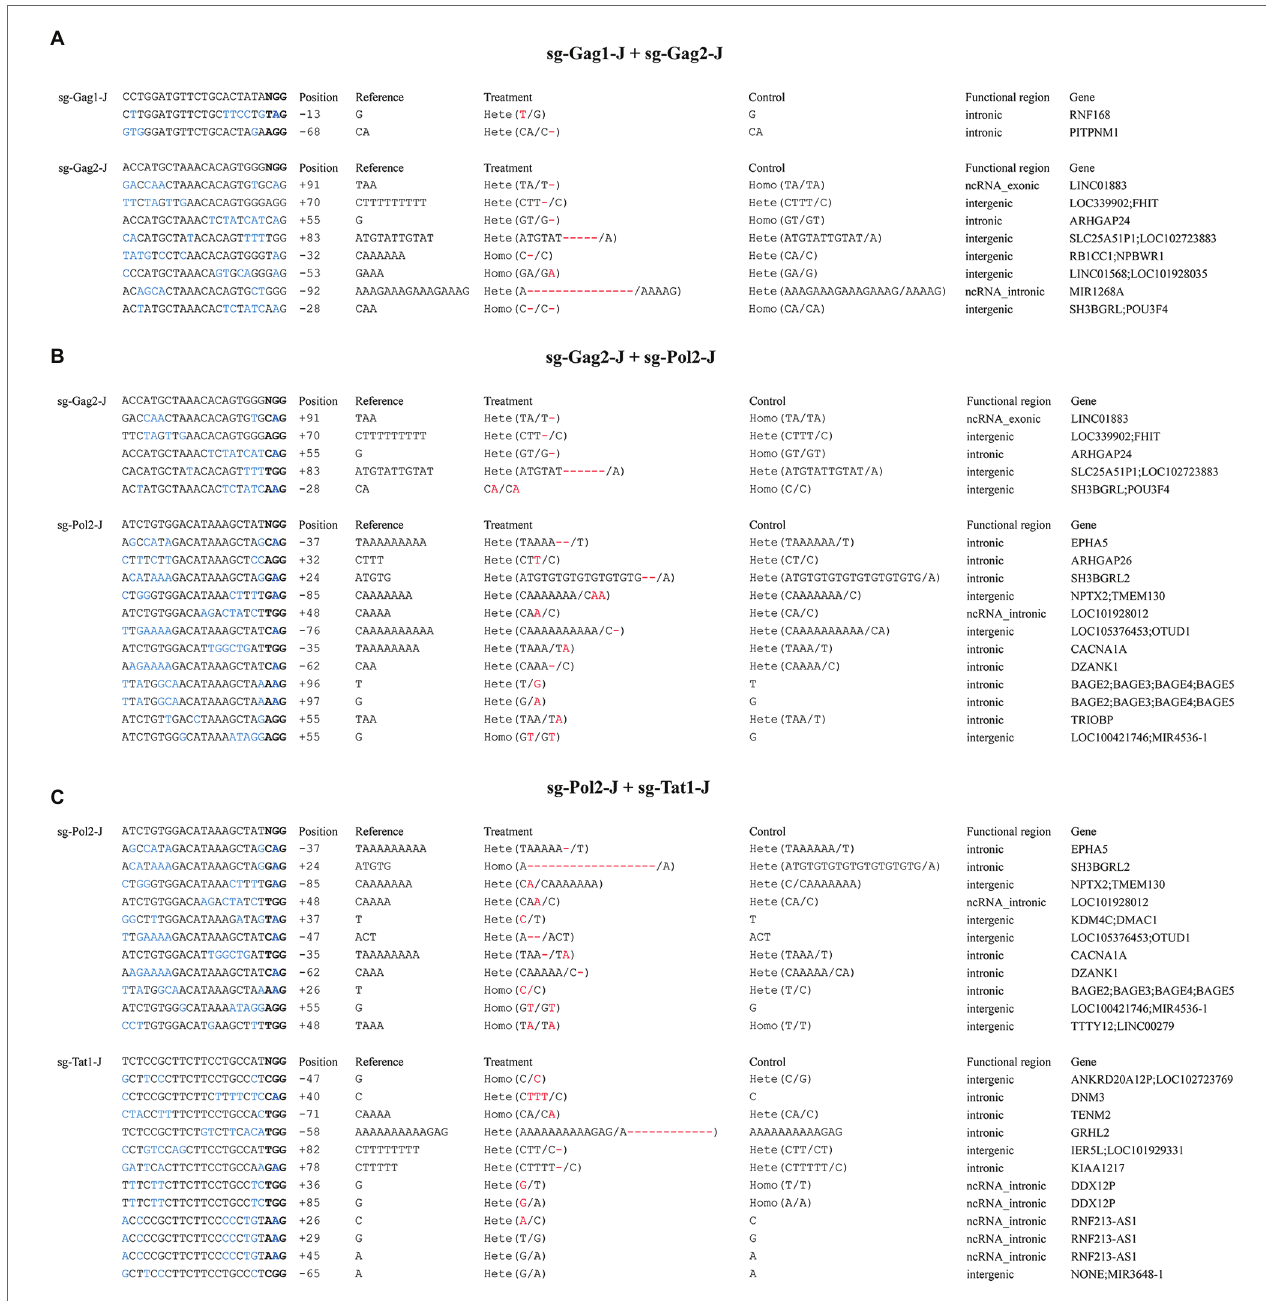
FIGURE 6 | Analysis of potential off-target sites using whole-genome sequencing (WGS). (A) sg-Gag1-J + sg-Gag2-J. (B) sg-Gag2-J + sg-Pol2-J. (C) sg- Pol2-J + sg-Tat1-J. In the potential off-target regions, mismatched bases to the sgRNAs are shown in blue and the bases in bold represent the PAM sequence; the position of the mutation sites is indicated by the relative distance to the 1st base (+1) of the 20 nt complementary regions; the differential mutations between the control and the treatment groups are highlighted in